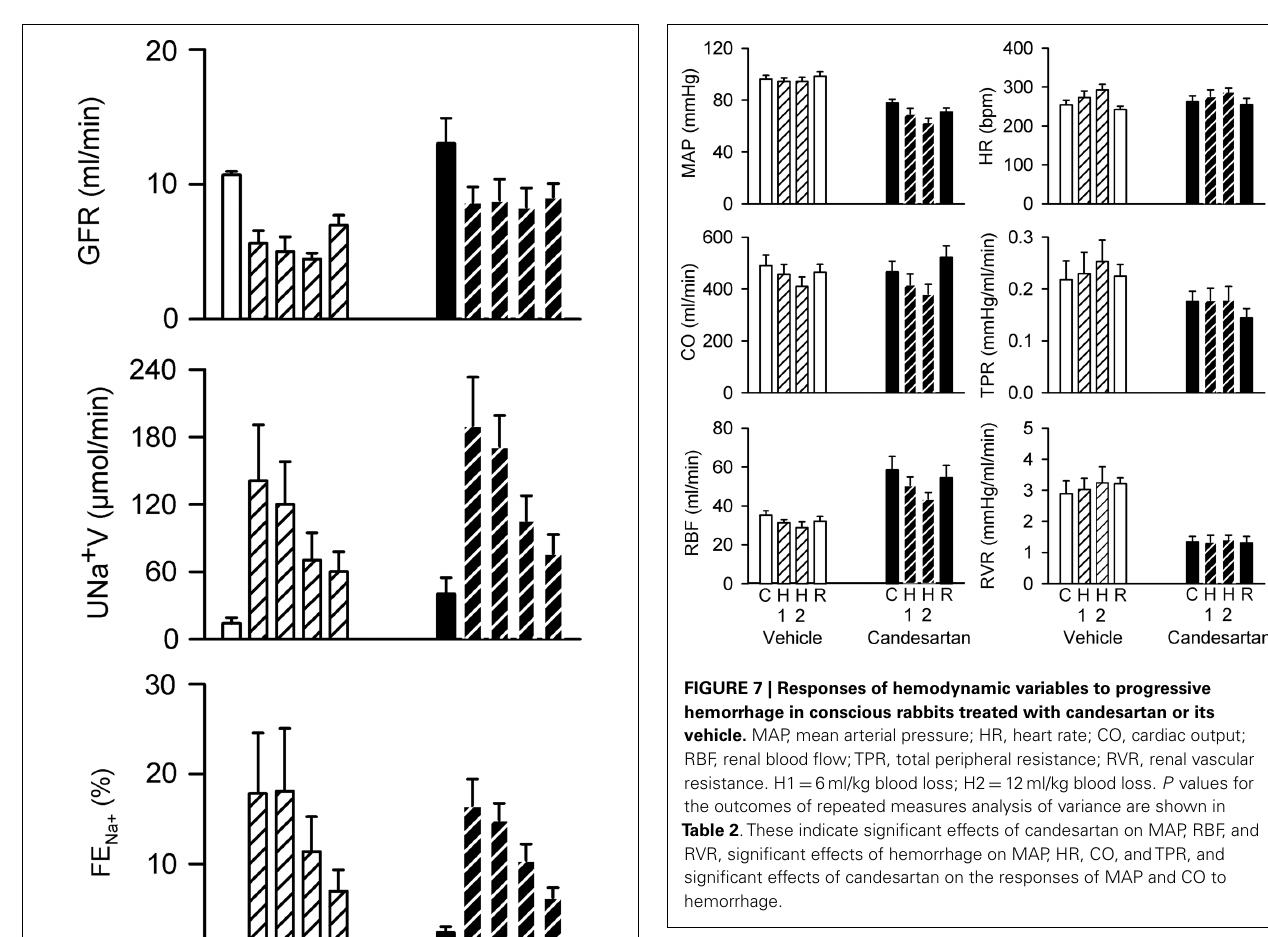
Table 2 .These indicate significant effects of candesartan on MAP, RBF, and RVR, significant effects of hemorrhage on MAP, HR, CO, andTPR, and significant effects of candesartan on the responses of MAP and CO to